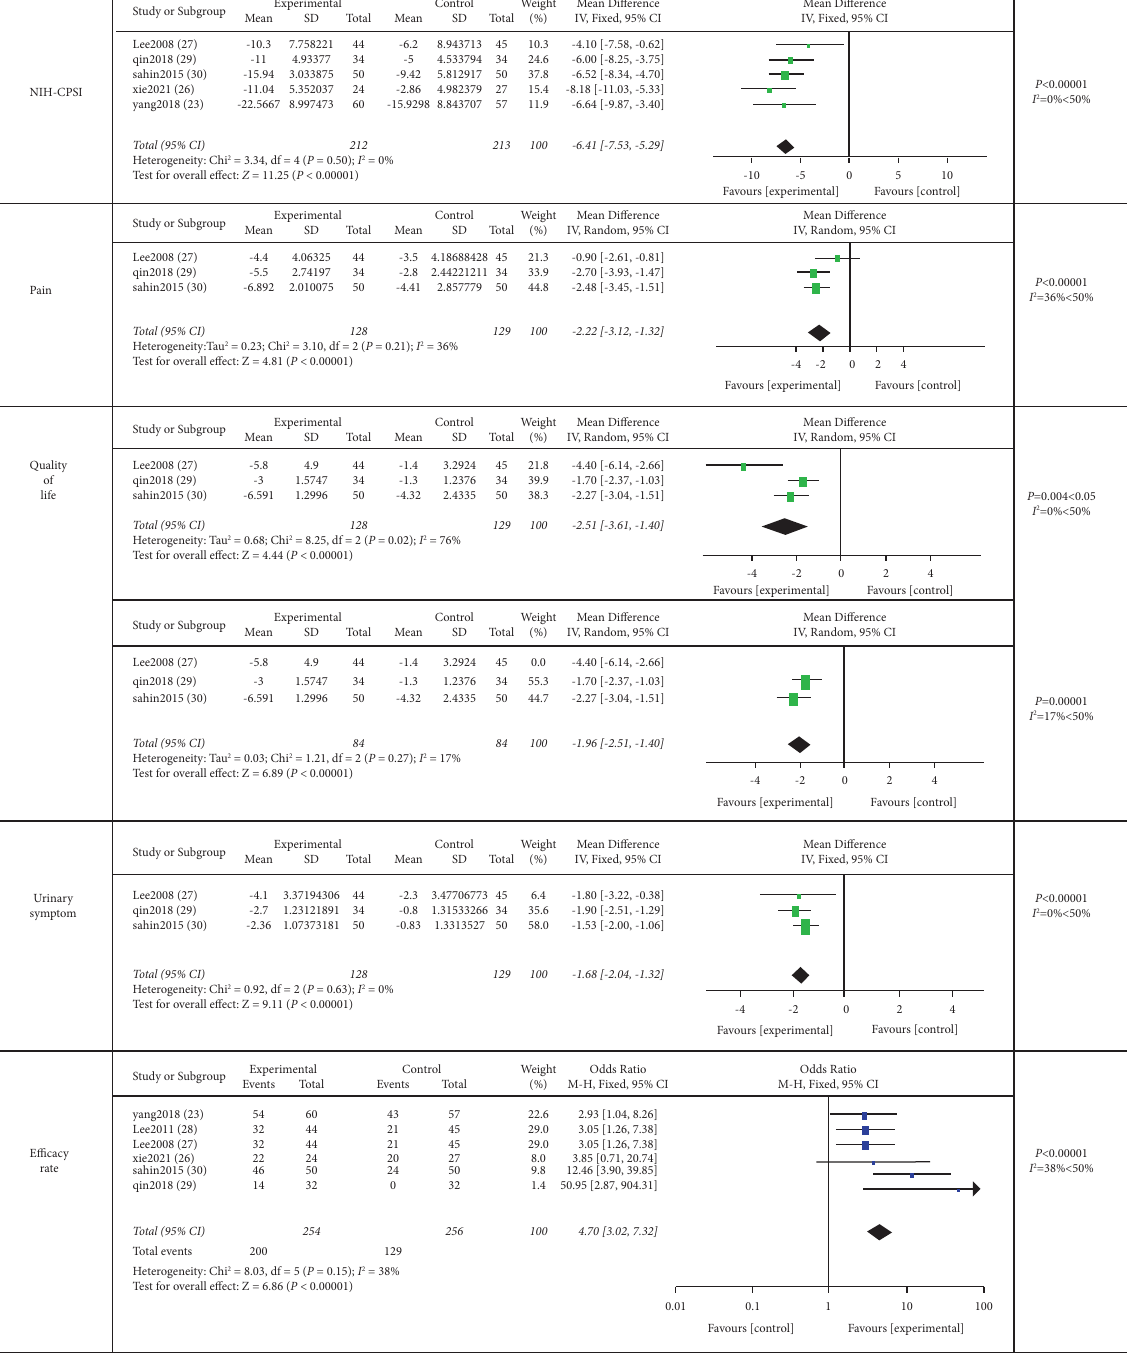
Figure 7: Meta-analysis on comparison of acupuncture verse sham acupuncture in pain, NIH-CPSI, quality of life, urinary symptom, and efcacy